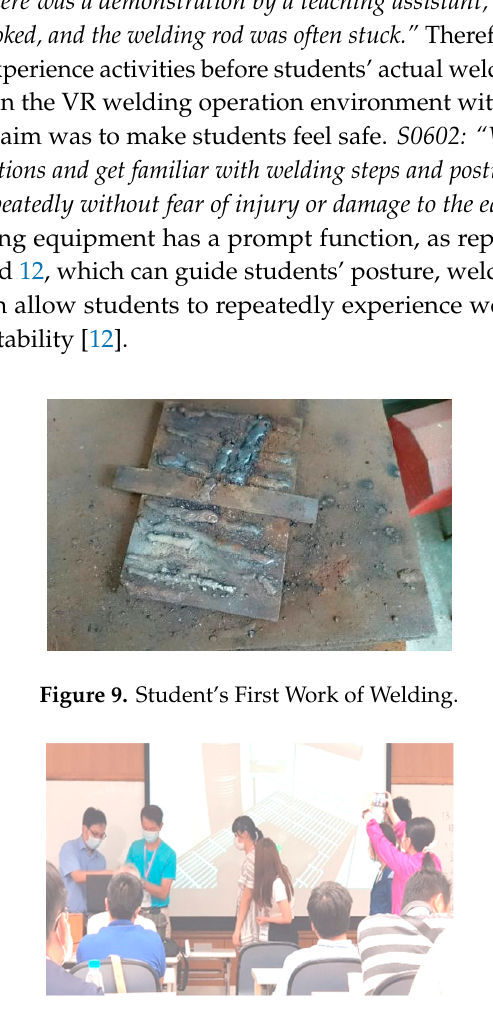
Figure 10. Teachers in VR-Assisted Welding Teaching.